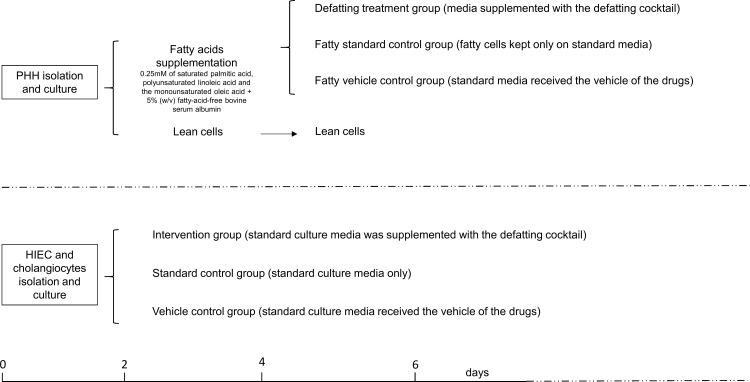
Study design.Series 1: Isolated primary human hepatocytes (PHH) were left in standard media for 2 days and then received media supplemented with fatty acids. After 2 days of fat loading the fatty PHH were allocated to the defatting treatment group where the media was supplemented with the defatting cocktail of drugs, and the control groups, the standard control group and the vehicle control group that received vehicle only. Lean hepatocytes were kept in standard culture conditions throughout the experimental period. The experimentation period lasted for two days thereafter. Series 2: Human intra-hepatic endothelial cells (HIEC) and cholangiocytes were immuno-magnetically separated with Dynabeads conjugated with cell-specific monoclonal antibody. The cells were left in culture for 2 days in standard media to reach confluence and then were allocated to the intervention group that received the defatting cocktail and the control groups, the standard control group and the vehicle control group that had the media supplemented with the vehicle only. The experimentation period lasts for two days thereafter.